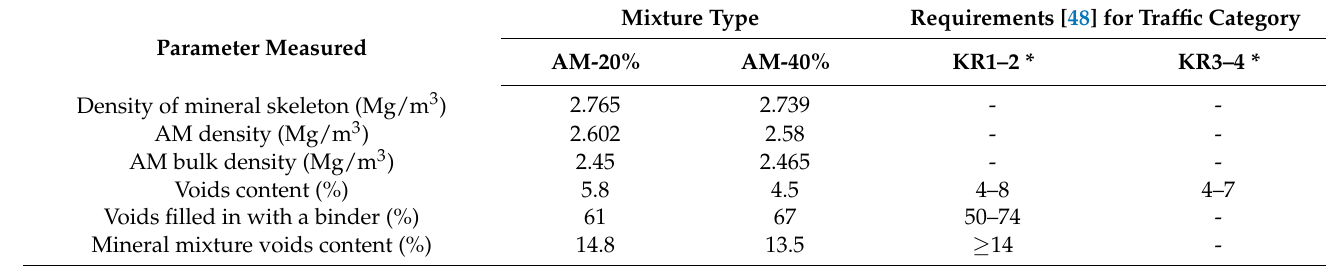
Table 5. Volumetric test results of